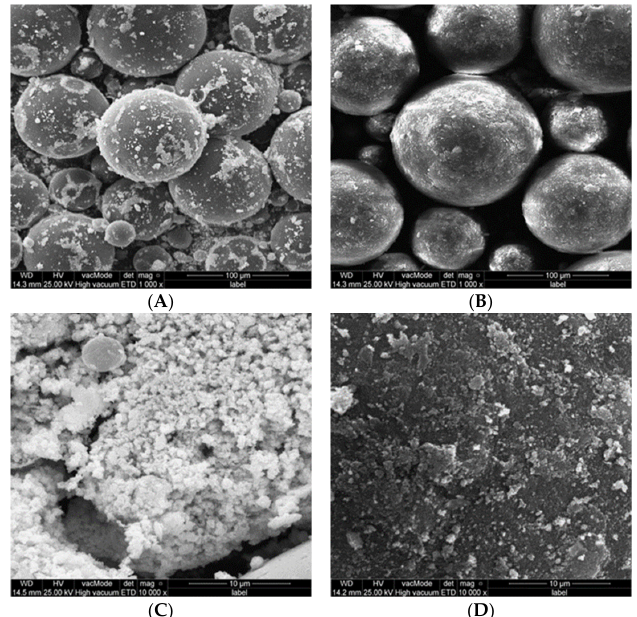
Figure 6. SEM photos of PMMA-MgO nanocomposite powder after non- ethanol-assisted ( A , C ) and ethanol-assisted ( B , D ) mixing.